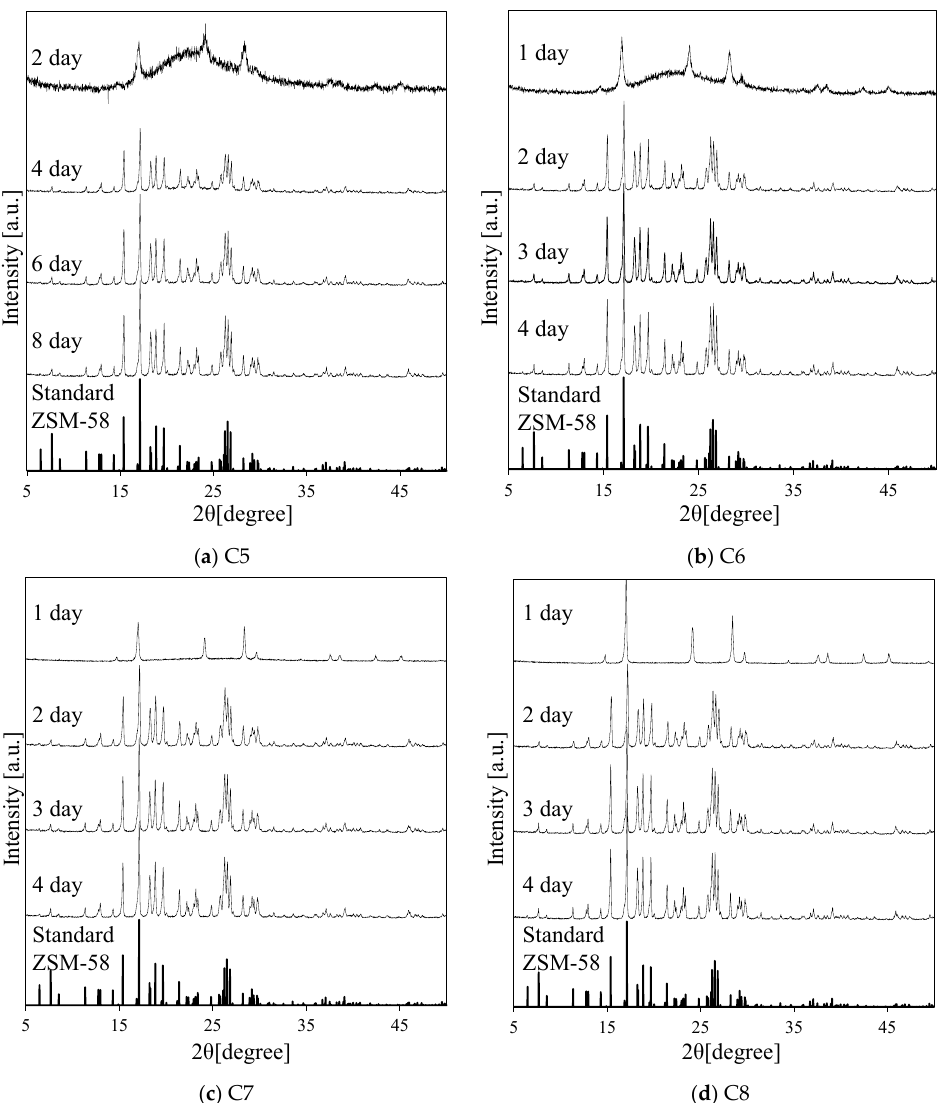
Figure 5. XRD profiles of the as-made crystals with various synthesis periods and gel compositions of ( a ) C5, ( b ) C6, ( c ) C7 and ( d ) C8 at 413 K.